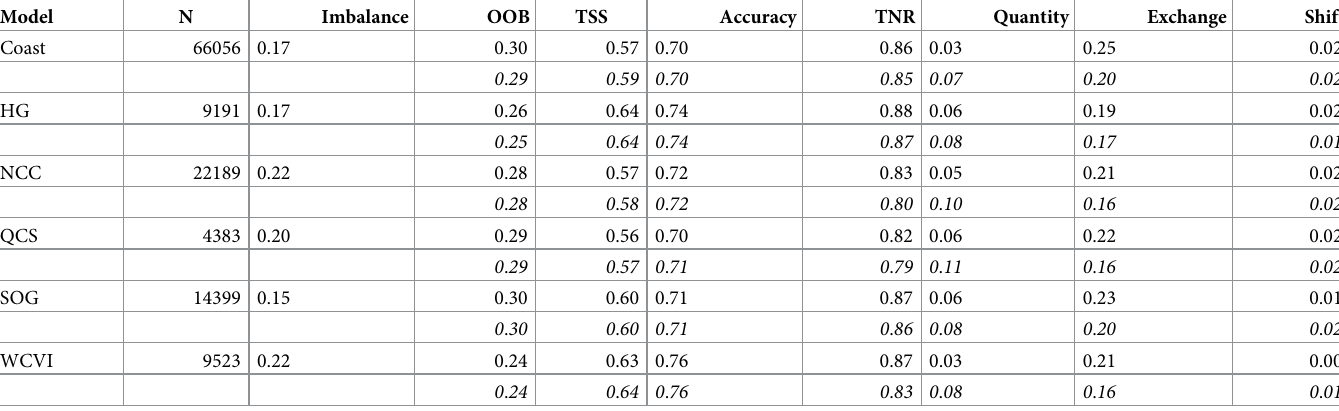
Table 3. Aggregated build metrics for all 6 models comparing the weighted (first row) and the unweighted (second row) random forest results. Model